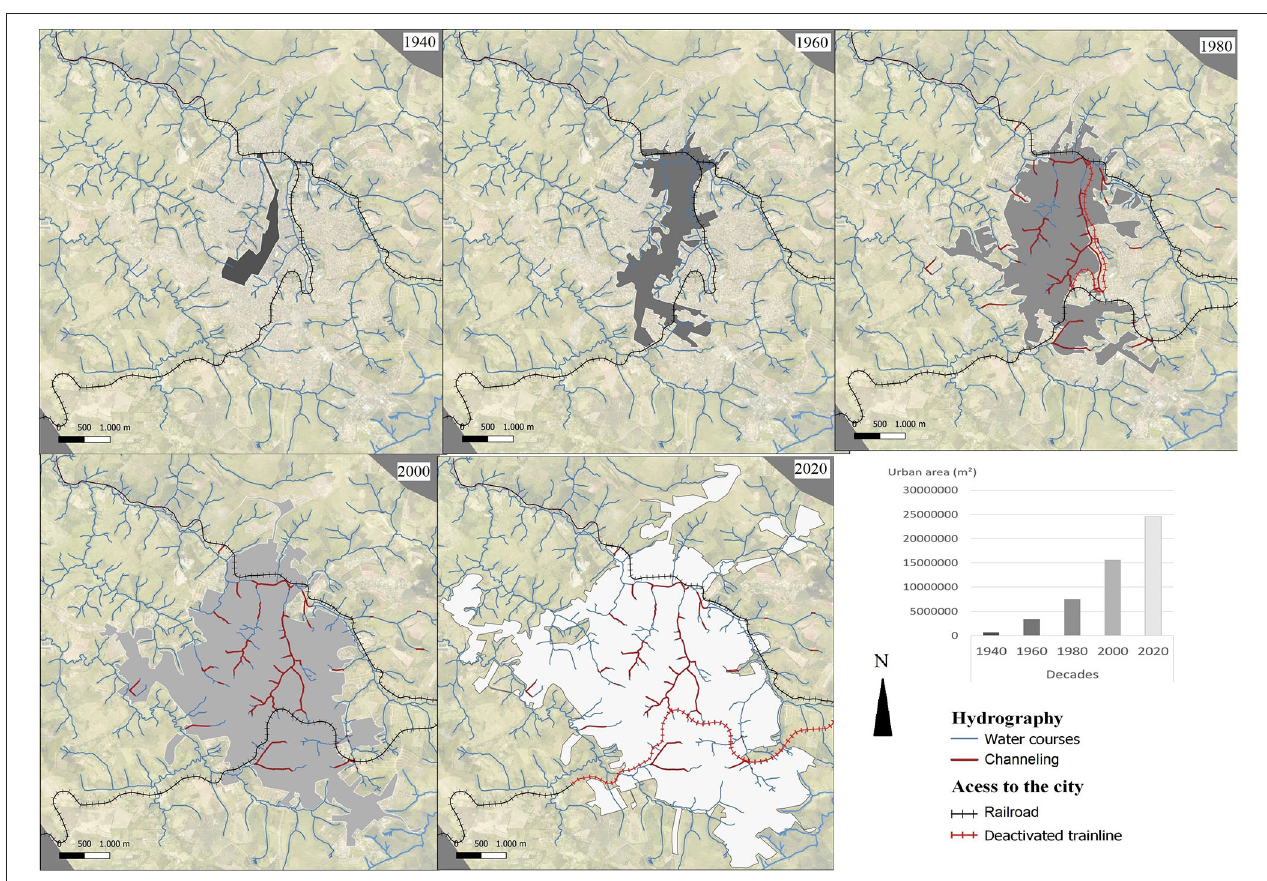
FIGURE 7 | Urban expansion of Lavras and its consequences for watercourses from the second half of the twentieth century to the first decades of twenty-first century. Source: Sousa R. B. et al.